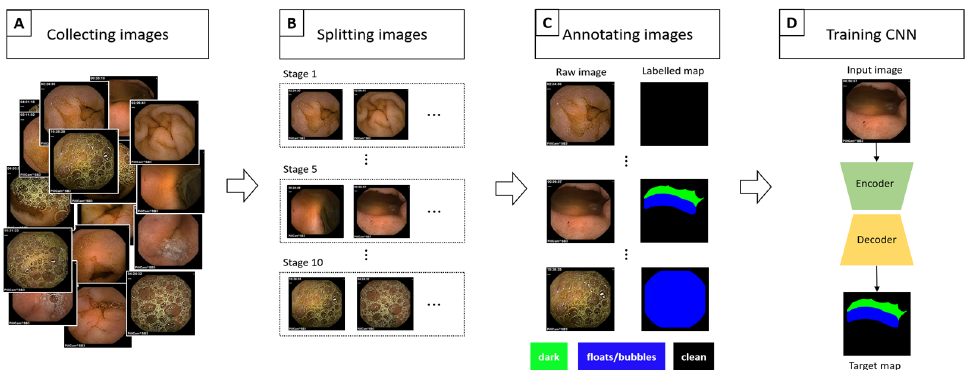
Figure 1. Overall flowchart of our semantic segmentation dataset construction. ( A ) We collected a set of raw images from CE. ( B ) Two gastroenterologists split the images into 10 stages according to the size of the clean area. ( C ) Each image was annotated by five well-trained annotators. ( D ) The quality of the constructed dataset was checked by training the CNN designed for semantic segmentation task.